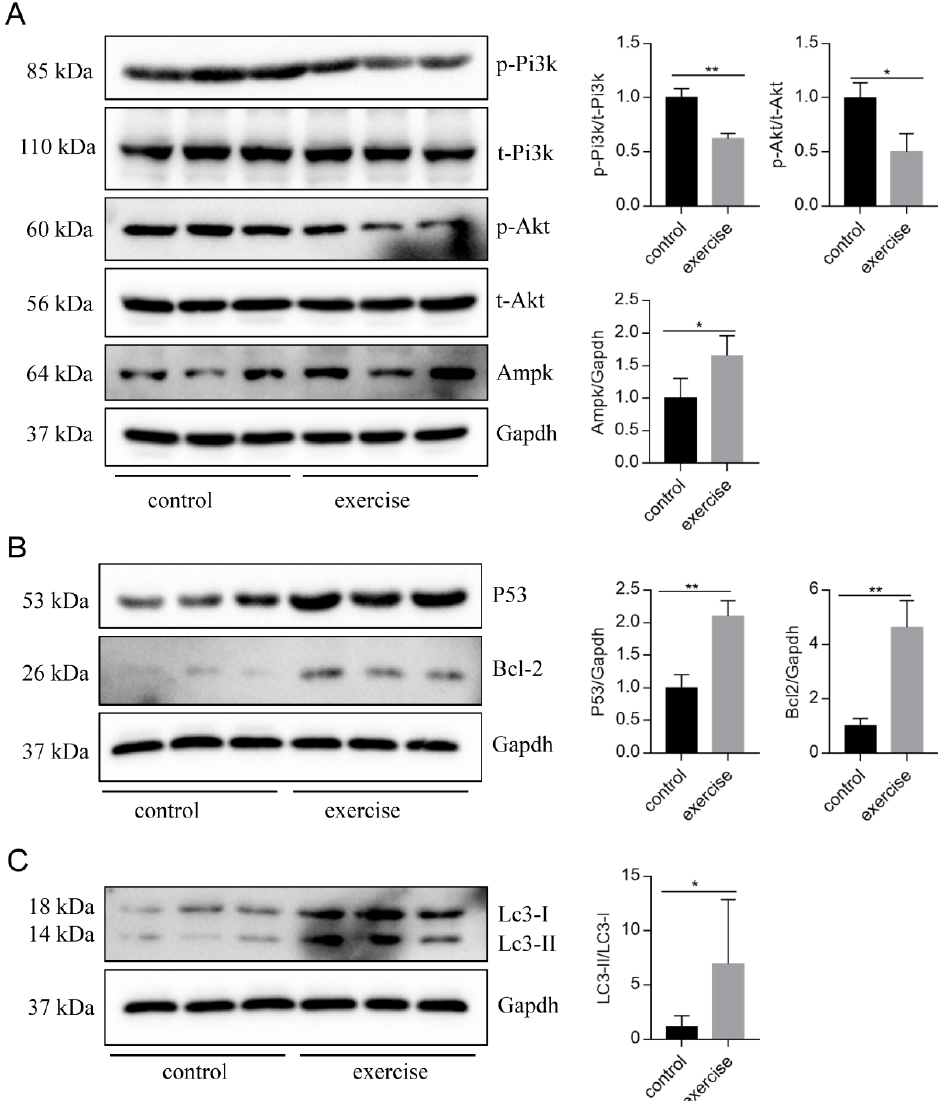
Figure 5. Western blot was used to validate key proteins in signals involved in excessive-exercise-induced muscle atrophy. ( A ) The expression of proteins in the PI3K–AKT signal (representative blot). ( B ) The expression of proteins in the apoptosis signal (representative blot). ( C ) The expression of proteins in the autophagy signal (representative blot). Right panels are quantitative analysis data of the protein expression level by Image J and GraphPad Prism. All uncut Western blot images are provided in Supplementary Materials. Data represent mean ± SD ( n = 6). * p < 0.05, ** p < 0.01.